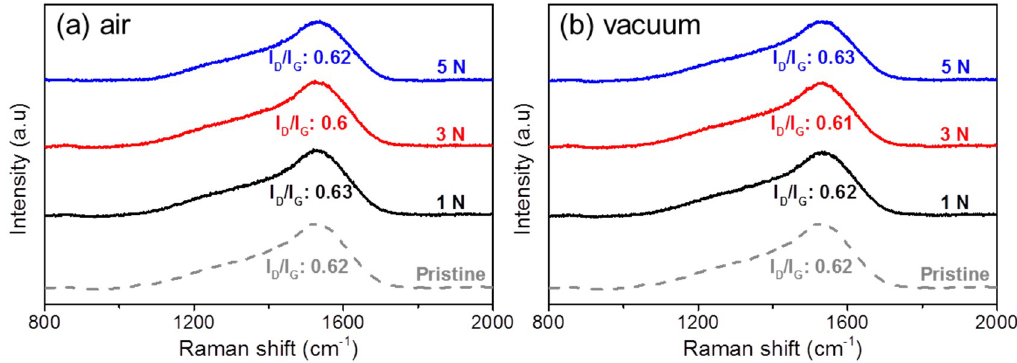
Figure 4. Raman spectra of worn surfaces on H-DLC films formed at various applied loads in ( a ) humid air and ( b ) vacuum.